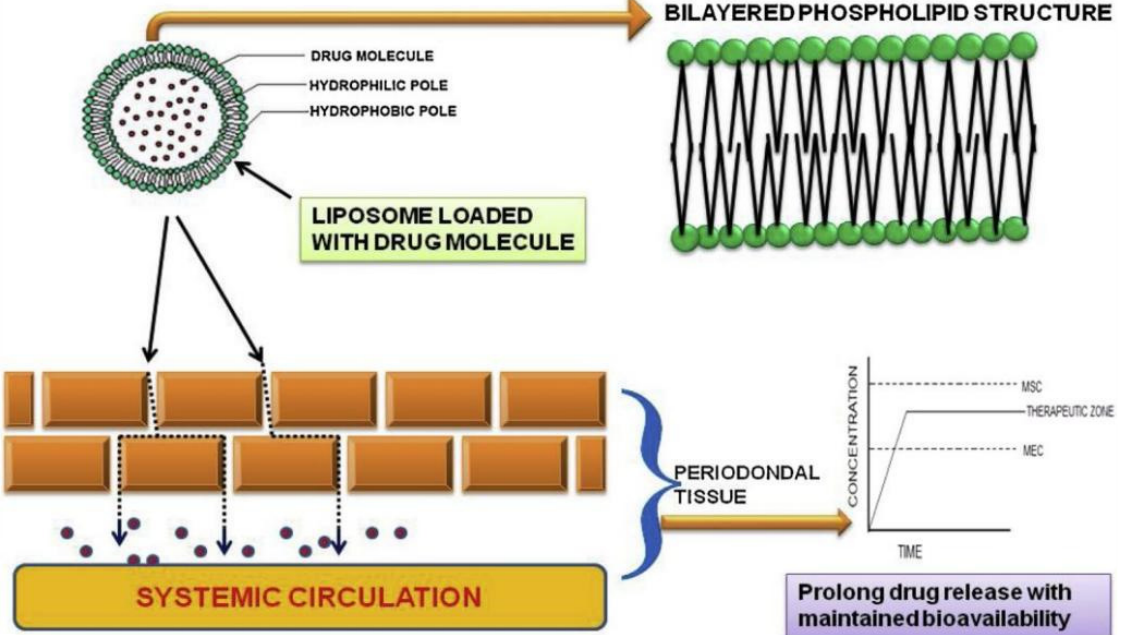
Figure 5. Schematic diagram of bi-layered structure of liposome with penetration into the periodontal tissue. Reprinted/adapted with permission from Ref. [62]. 2019, Suresh, P.K.